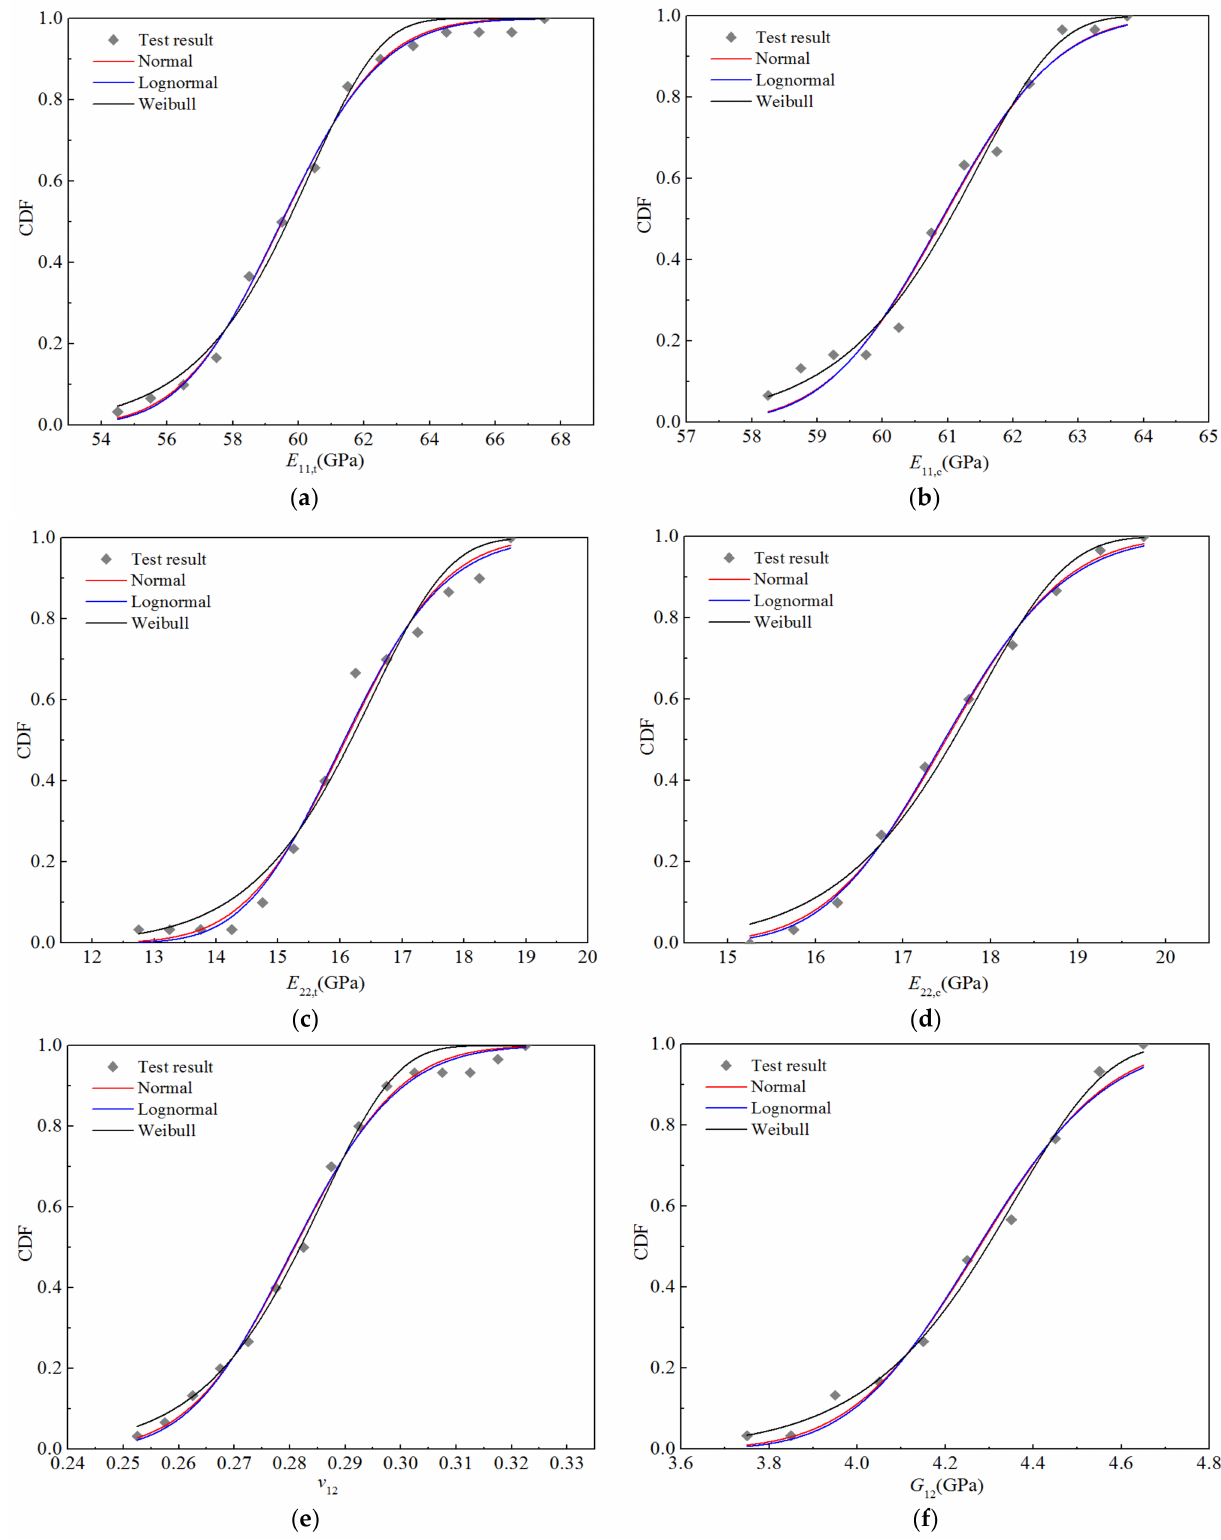
Figure 6. Fitting curves for the stiffness properties of H-GFRPs at RT. ( a ) E 11,t , ( b ) E 11,c , ( c ) E 22,t , ( d ) E 22,c, ( e ) v 12 , ( f ) G 12